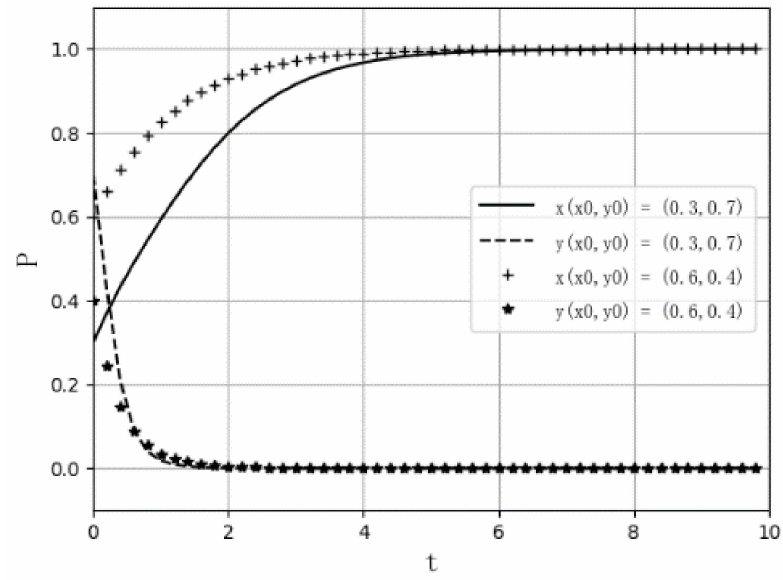
Figure 8. Path diagram of the evolutionary game of Scenario 2 (I 2 + B > I 3 + R 2 − F and G 1 − G 2 < A). (3) Scenario 3: I 2 + B < I 3 + R 2 − F, G 1 − G 2 > A and I 1 − R 1 − ( I 2 − R 2 ) + I 2 + B − − F + R ( I ) > 0. There may exist two stable equilibrium strategy combinations 3 2